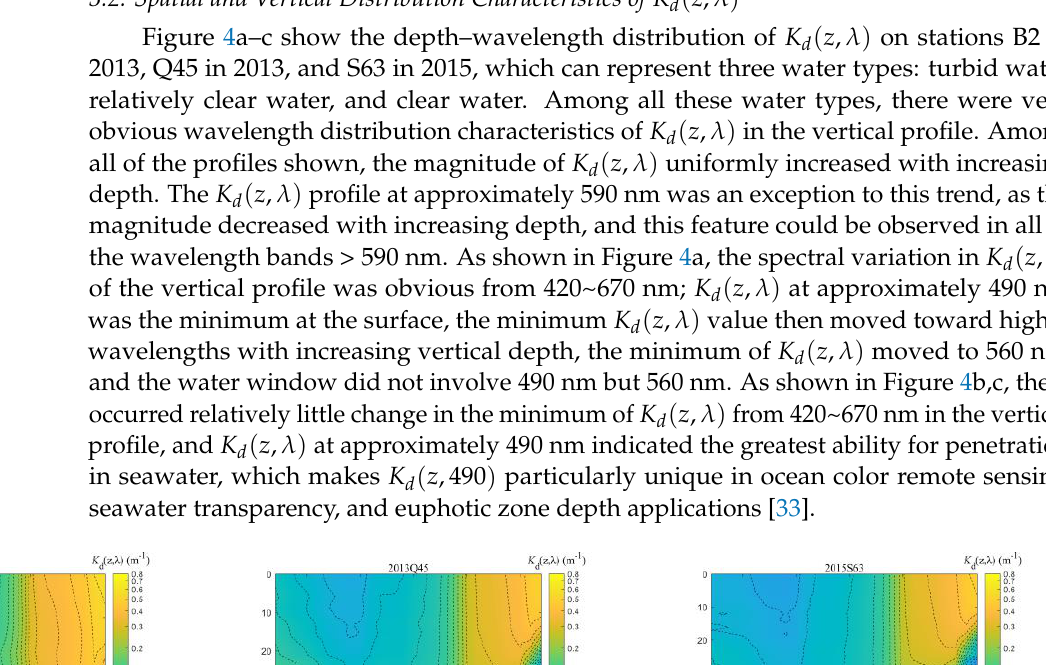
Figure 3. Spectral characteristics of K d ( z , λ ) : ( a ) all stations of this study; ( b ) Jerlov’s oceanic water type.